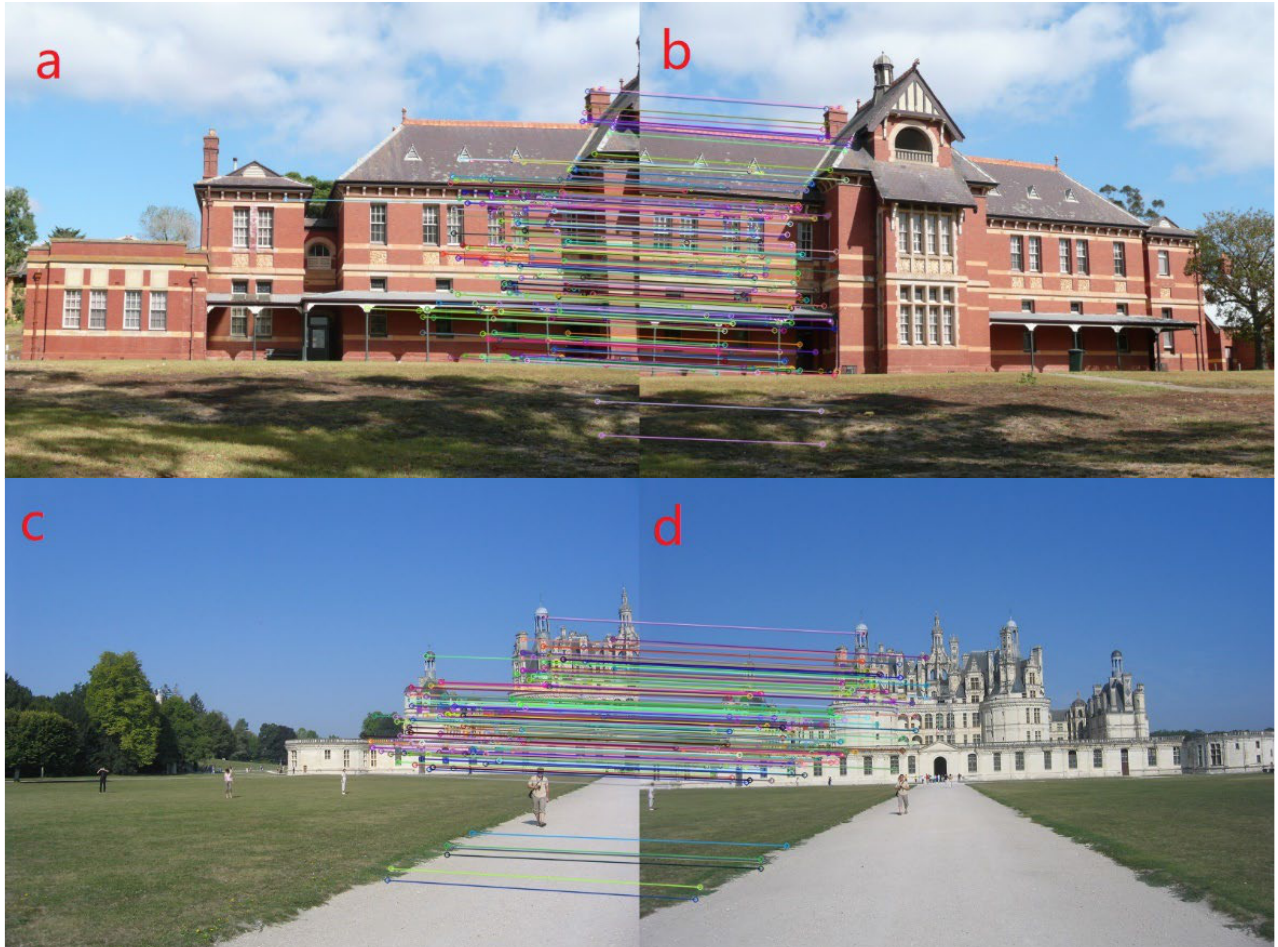
Figure 1. Pairs of subfigures, ( a – d ), are the results for matching image feature points using A-KAZE and KNN algorithms.